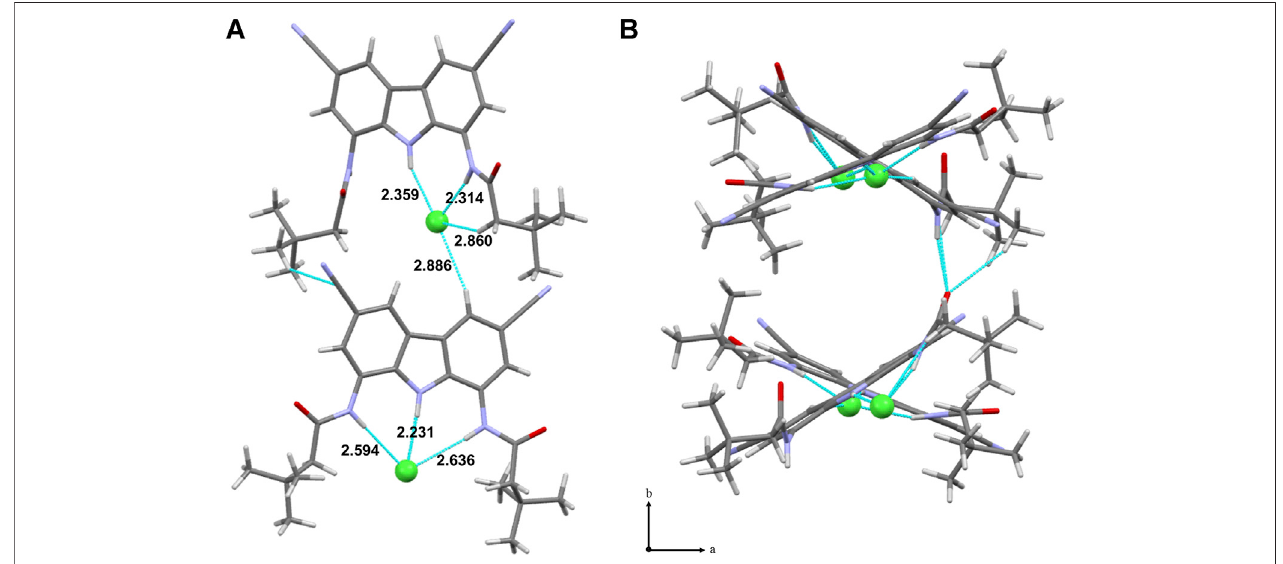
FIGURE3| X-raycrystalstructureof 9 × TBACl;theTBA + countercationswereomittedforclarity.Hydrogenbondsbetween 9 andCl − arecoloredintolight-blue.a) view along [010] direction; b) packing of 9 × TBACl, view along [001]